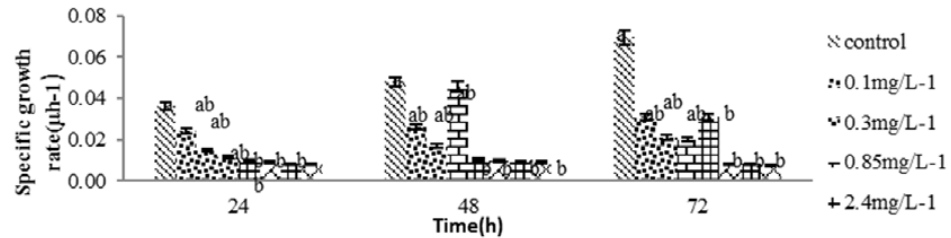
Fig. 3. Growth percent inhibition (I) of Dunaliella salina in contact with SiO 2 NPs Notes: Treatments with at least one commonality are statistically significant ( p <0.05).